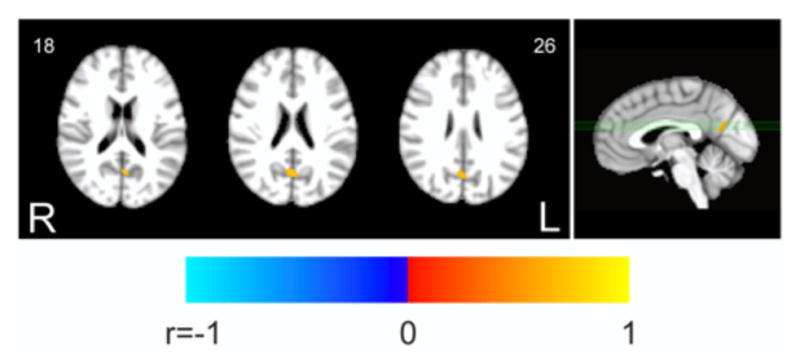
Correlation between fALFF and FC changes within the DMN. The map shows the voxelwise thresholded results of correlation analysis between task-related changes of fALFF and FC. Decrease of fALFF was correlated to decrease of FC in a small single cluster within the posterior DMN areas (p < 0.05 corrected. 3dClustSim parameters: single-voxel p < 0.001; cluster size threshold, 16 voxels).